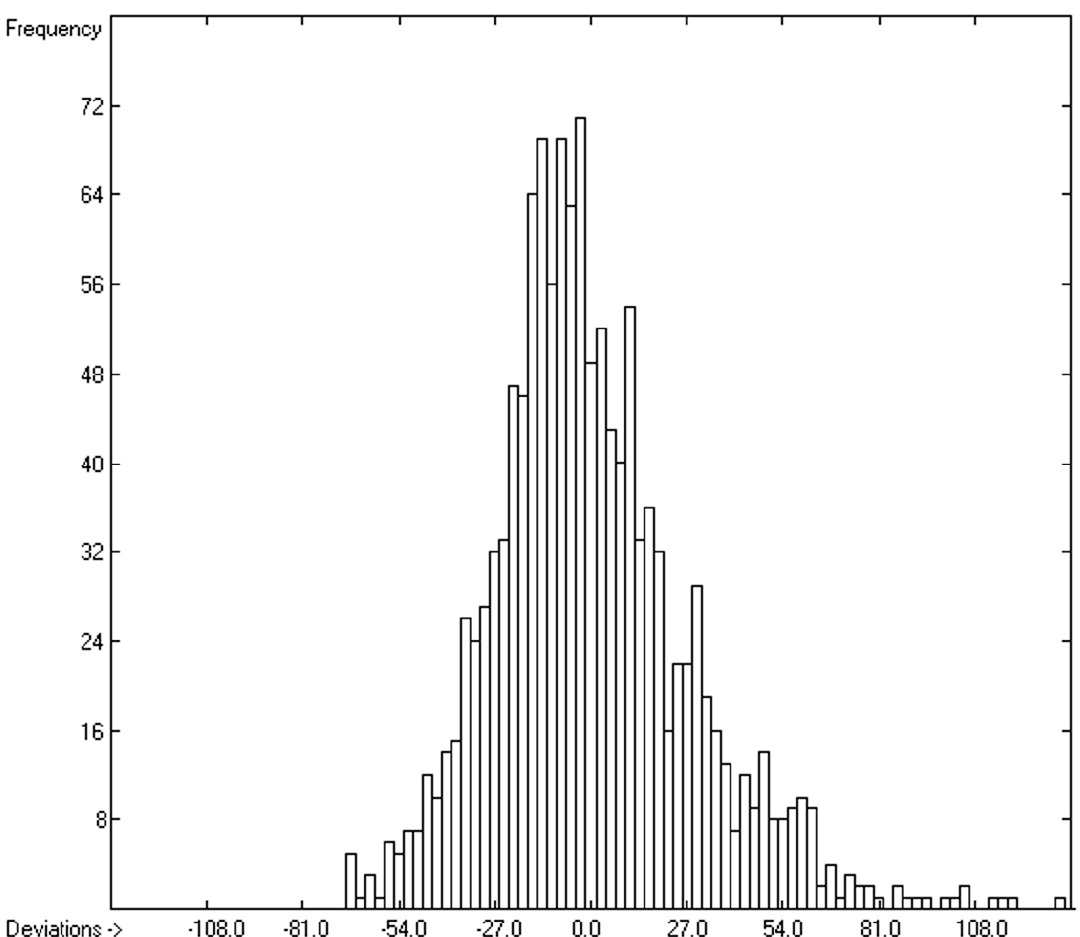
Figure 3. Histogram of molecular volumes with Cp(liq) at 298.15 K. Values range from 75.32 to 1956.10 J/mol/K.